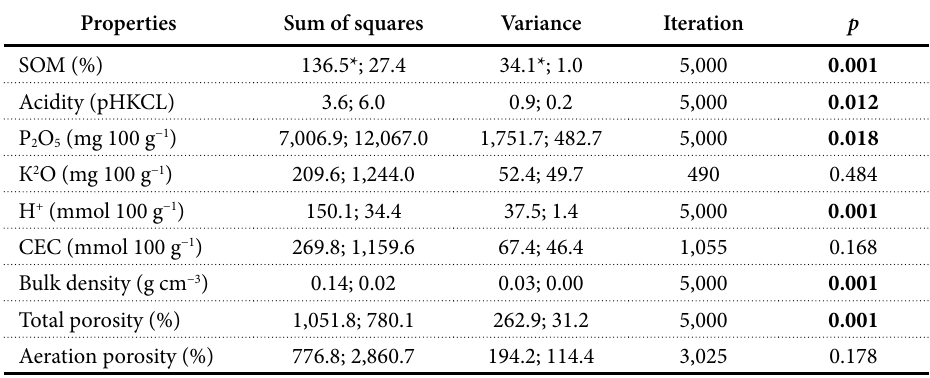
Note: * first value – between treatments; second value – within treatments; boldface – a significant difference.